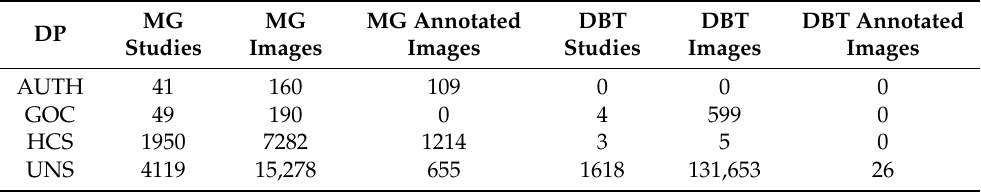
Table 3. The number of studies, images, and annotated images for MG and DBT in the INCISIVE retrospective data